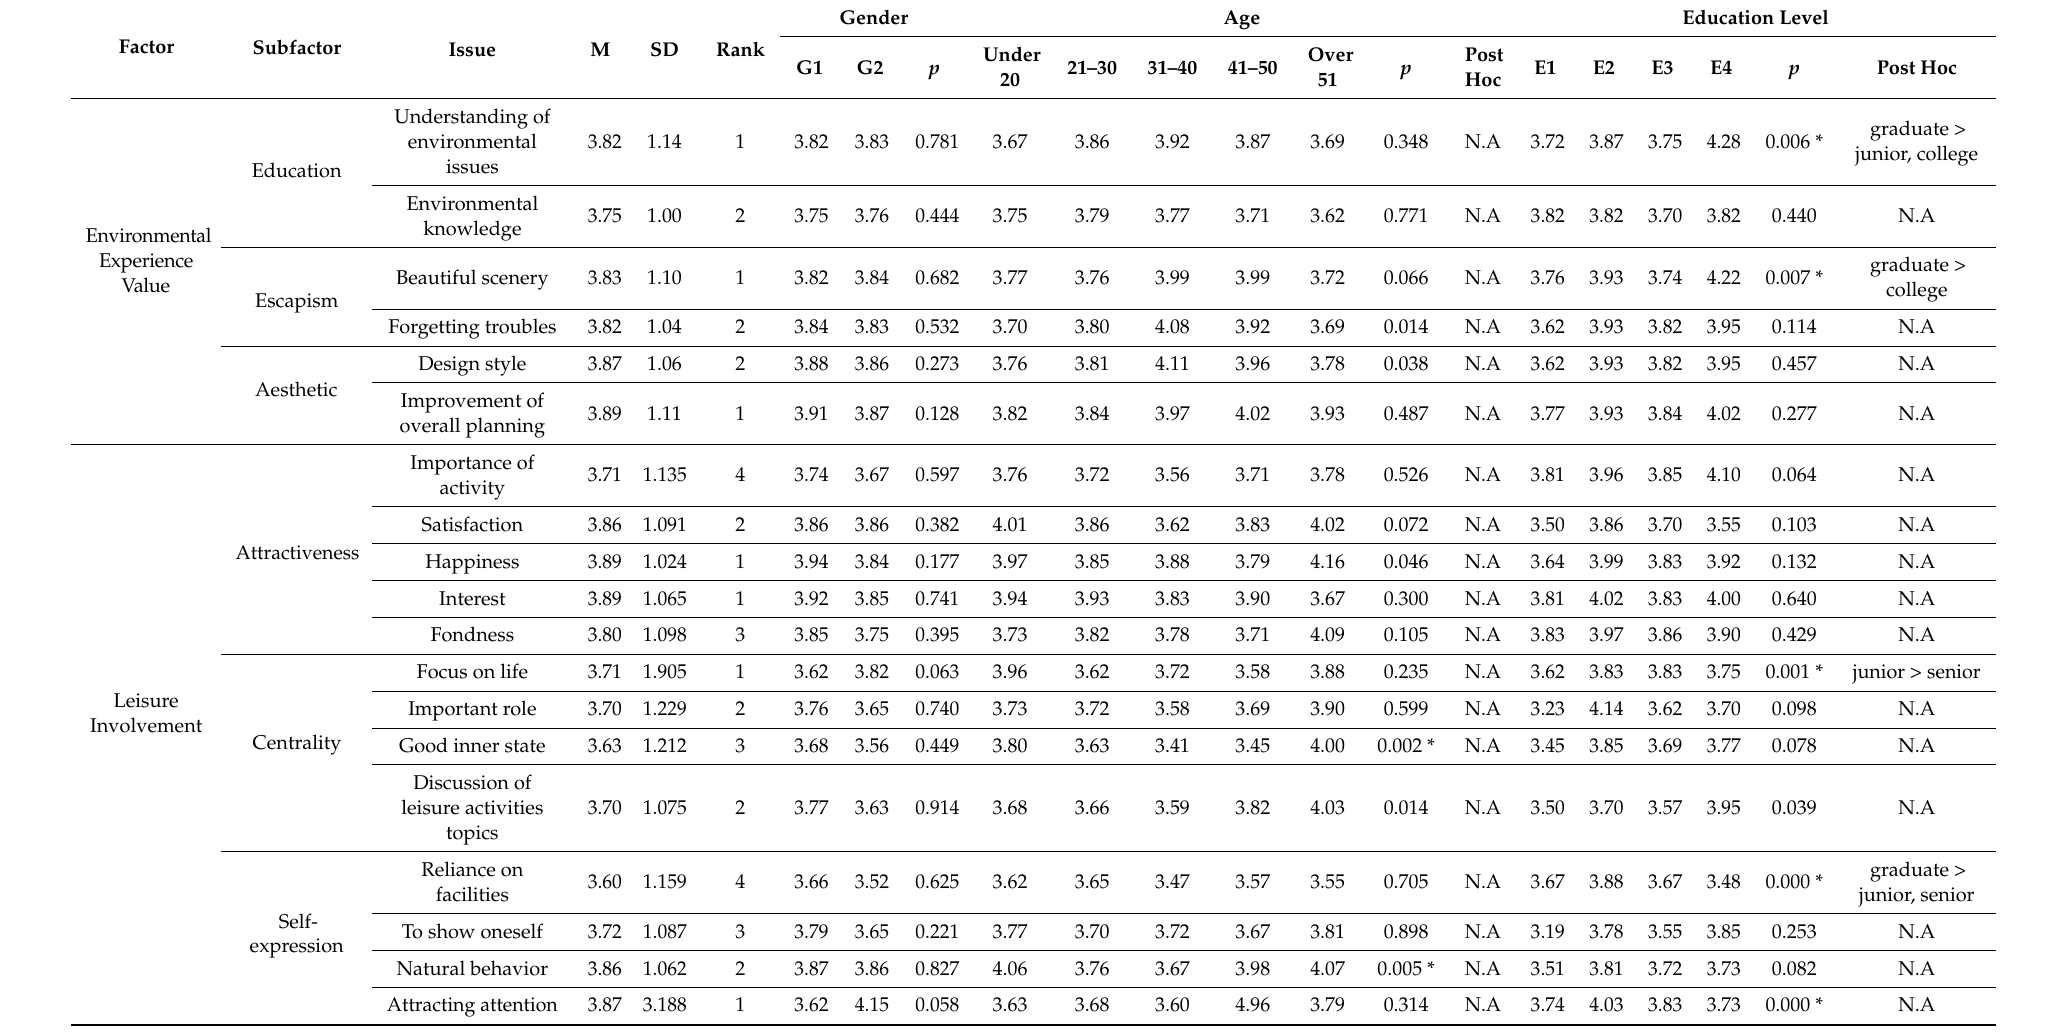
Table 2. Analysis of cognitive differences in environmental experience value, leisure Involvement, leisure satisfaction, and well-being (environmental experience value and leisure